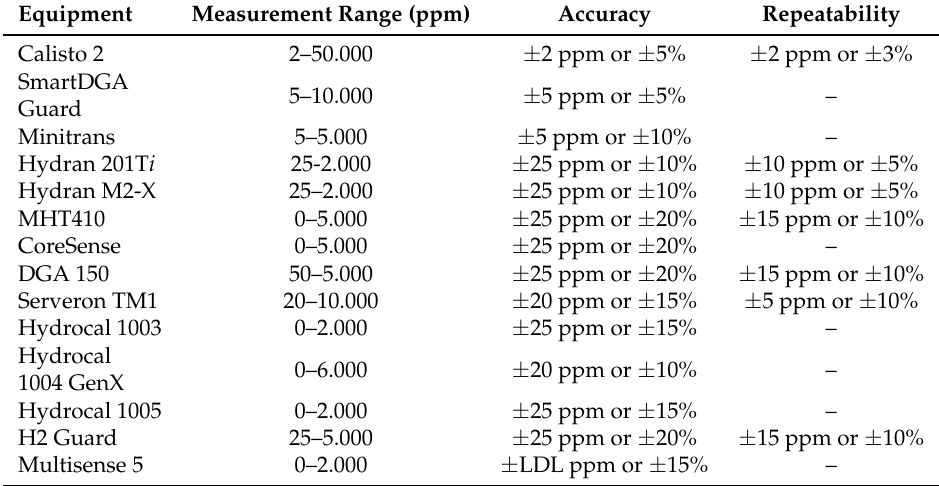
Table 7. Hydrogen concentration measurement range, accuracy and repeatability of fault detection monitors (as indicated by